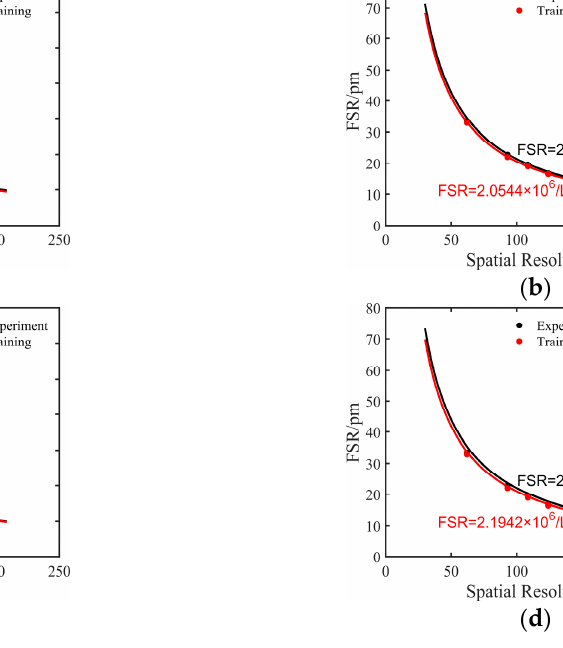
Figure 5. Comparison of free spectra range between experimental and training spectra at strain of ( a ) 100, ( b ) 1000, ( c ) 2000, and ( d ) 2900 µ ε : L, spatial resolution.